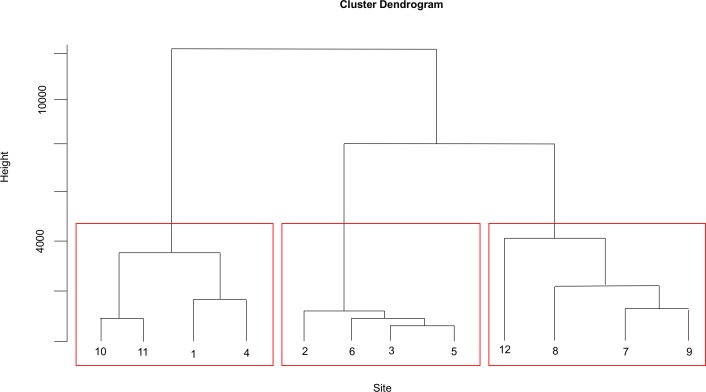
Cluster analysis dendrogram.